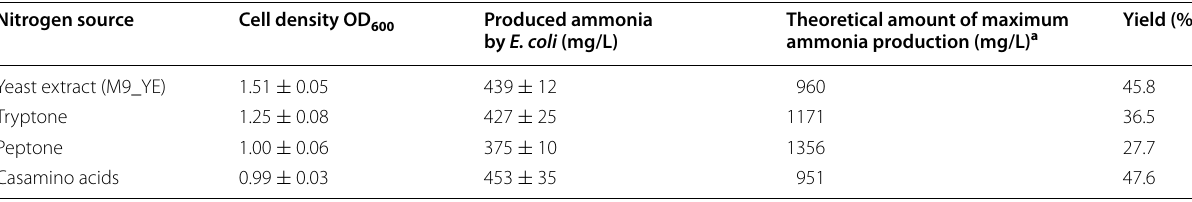
Δ glnA strain with various nitrogen sources (7.25 g/L) +